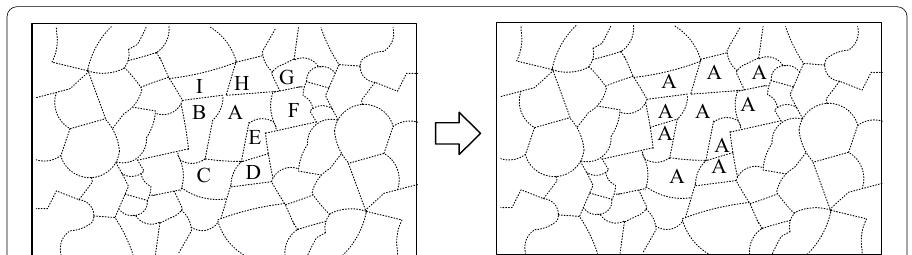
Fig. 5 Illustration of the region combination